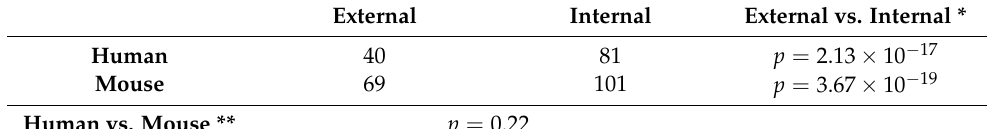
Methods for details).